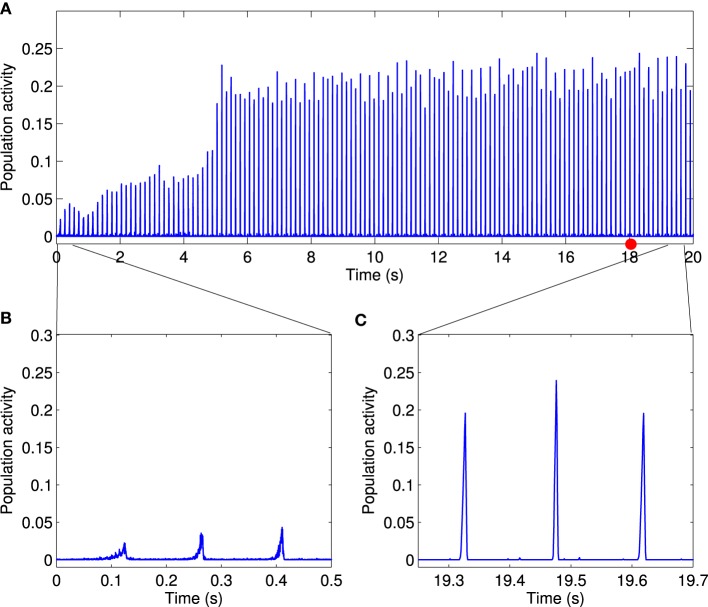
Global synchronous activity is established by local excitation. (A) In presence of local excitation, after about 5 s simulation time, global synchrony emerges in the network. Periodic network activity with relatively large amplitudes indicates that the system is in a one-cluster state. Insets of the network activity at magnified time scale show that (B) in the transient state synchronized network activity emerges gradually and (C) activity peaks are precise in the steady state. Thus, local excitation enables the network to overcome the disorder in the firing rate of neurons and to establish global synchronous activity. We used one particular population burst [shown by red circle in (A)] to show reliable synchronous activity propagation in Figures 4A,B.